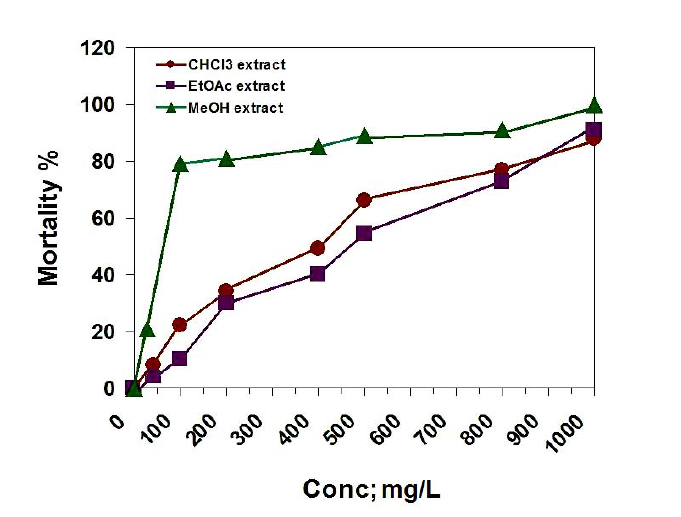
Figure 3. The cytotoxic activity of D. repens CHCl brine shrimp ( A. salina